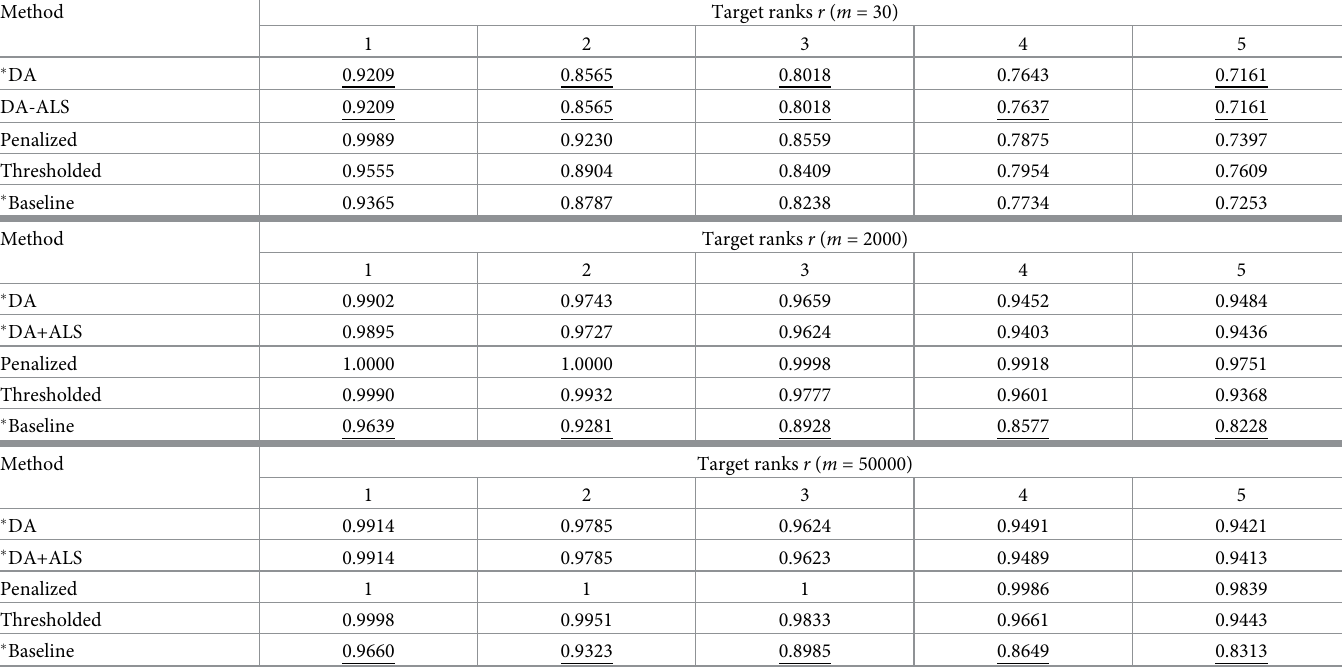
* Bernoulli(0.2). The � symbol indicates methods we propose. Best results are ij